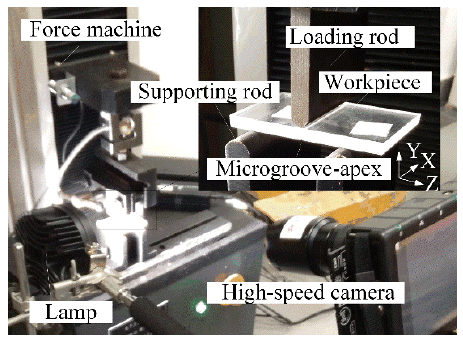
Table 2. Micro-grinding conditions of microgroove on workpiece substrate.